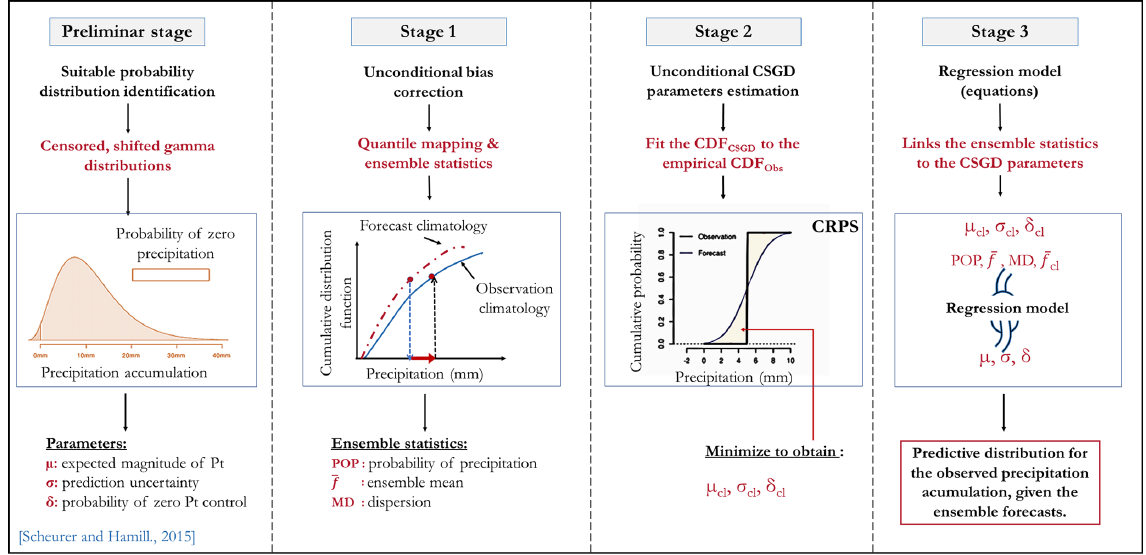
Figure 1. Stages of the CSGD precipitation post-processor.